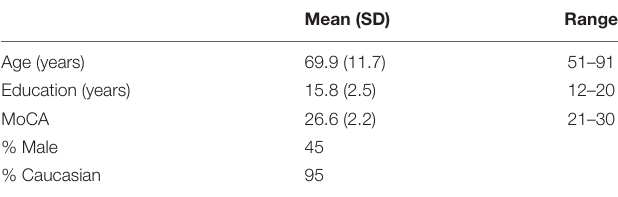
TABLE 2 | Participant